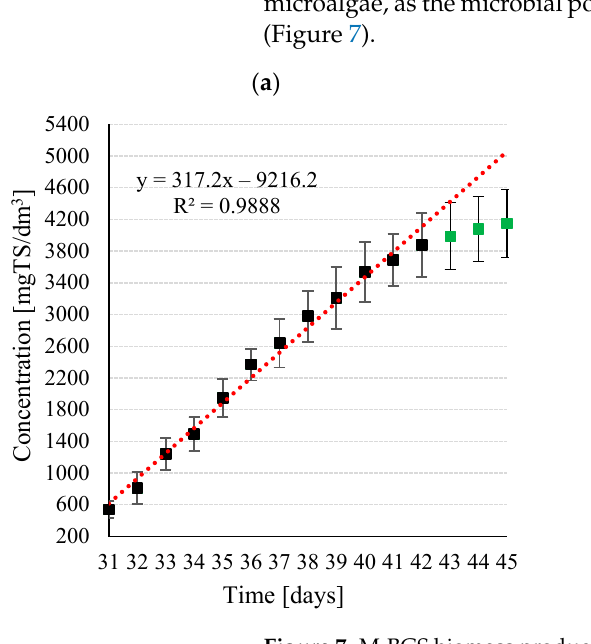
Figure 7. M-BGS biomass production in phases: ( a ) phase 3 (days 31–45) and ( b ) phase 4 (days 46–60) of the H-PBR operation.